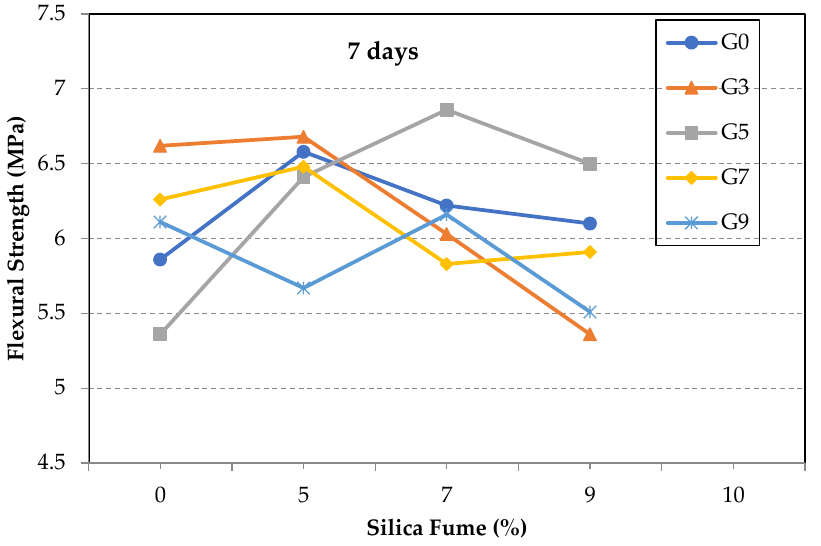
Figure 3. Flexural strength of test specimens at seven days.